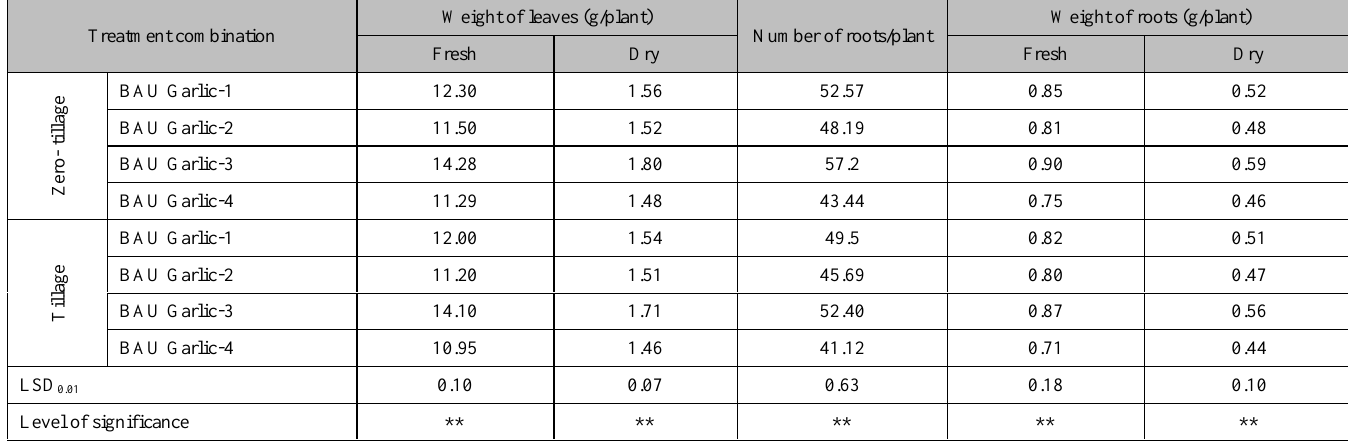
Table 5. Combined effects of planting system and variety on fresh weight, dry weight of leaves, number of roots, fresh weight and dry weight of roots. Treatment